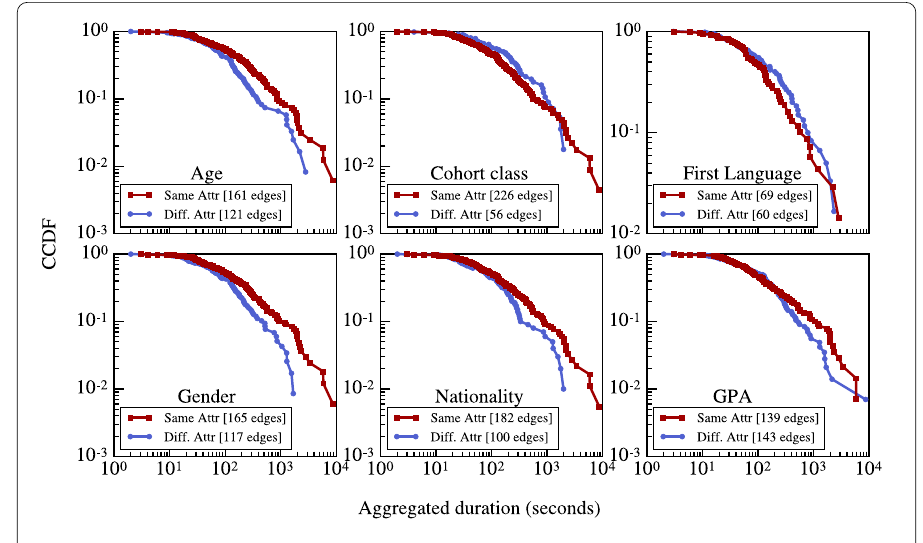
Figure 8 Complementary cumulative distribution function (CCDF) of the edge weights in the yearly aggregated communication network, for edges linking nodes with either the same attribute or different values. Results are shown separately for different attributes